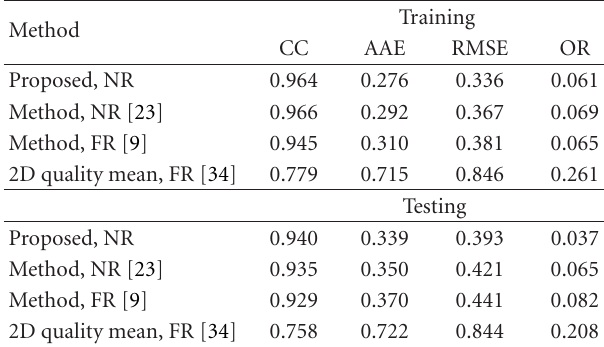
Table 6: Evaluation results comparison on MICT